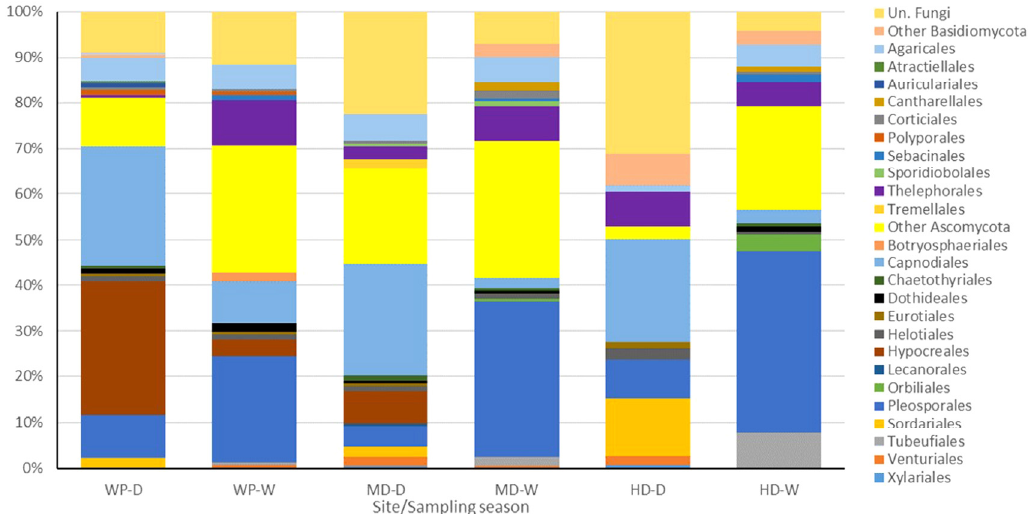
Figure 3. Abundance of different fungi orders in litter samples from forest sites with different levels of disturbance (well preserved: WP; moderately disturbed: MD; heavily disturbed: HD) in central Mexico in two contrasting seasons (dry season: D; rainy season: W). Un. = unidentified. Table 4. Jaccard similarity index of fungal OTUs in forest sites with different levels of disturbance (well preserved: WP; moderately disturbed: MD; heavily disturbed: HD) in central Mexico in two contrasting seasons (dry season: D; rainy season: W). WP ‐ W MD ‐ D MD ‐ W HD ‐ D HD ‐ W WP ‐ D 0.253 0.352